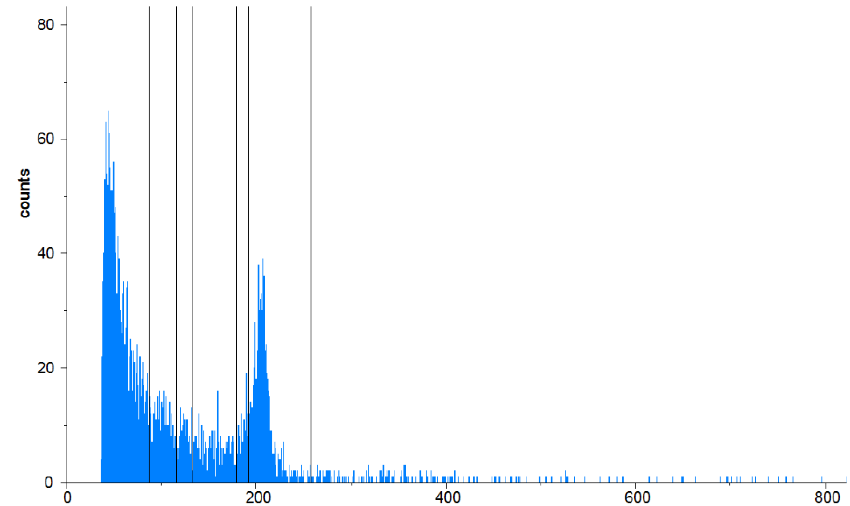
Figure 3. Argania spinosa flow cytometry profile 2, cells count represented on the Y axis while fluorescence intensity is represented on the X axis